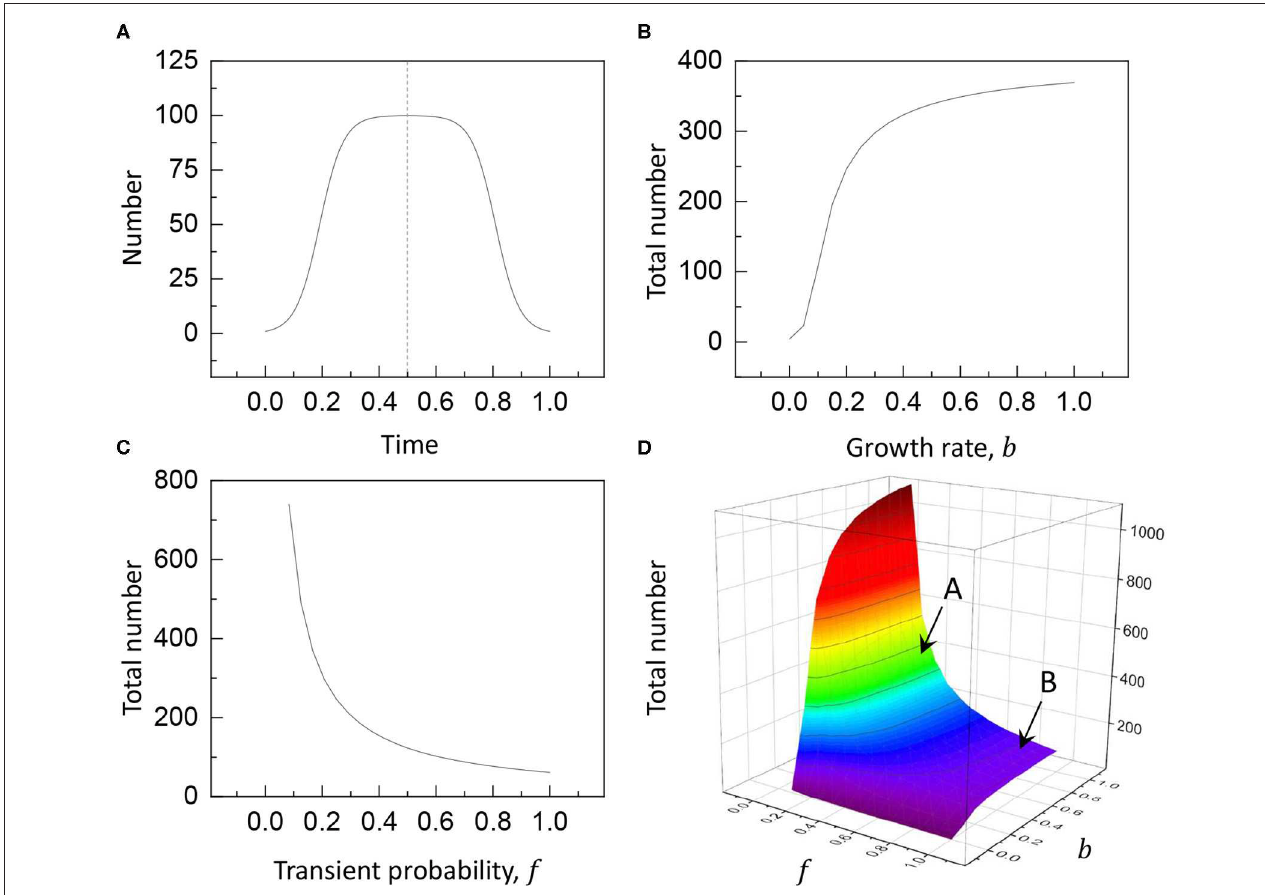
FIGURE 2 | The logistic model: (A) the particle number n ( t ) changes with time [ a = 1.0, b = 0.2, c = 100, d = 30, and e = 120], (B) by the contribution of the growth rate b [by fixing a = 1.0, c = 100, d = 30, and e = 120], (C) by the contribution of the transient probability f [by fixing a = 1.0, b = 0.2, c = 100, and e = 120], and (D) by the collective contribution of the growth rate b and the transient probability f [by fixing a = 1.0, c = 100, and e = 120]. Here, the total number increases by 3.7 times when the transient probability decreases to f = 0.25 (mobile particles, marked A) from f = 0.95 (static particles, marked B) for the same growth rate b =